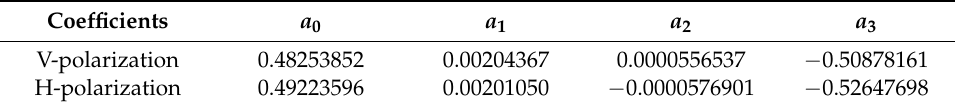
Table 1. Regression coefficients at two polarizations in Equation (8).